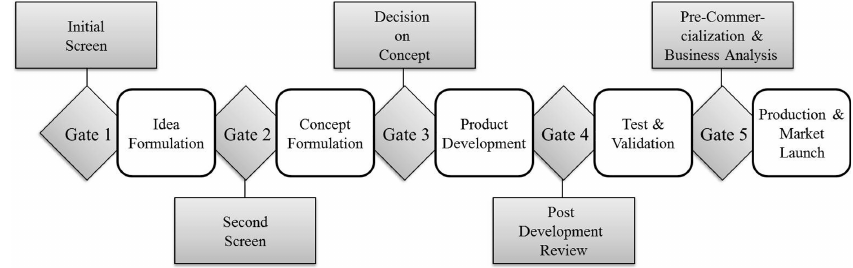
Figure 5. Stage gate